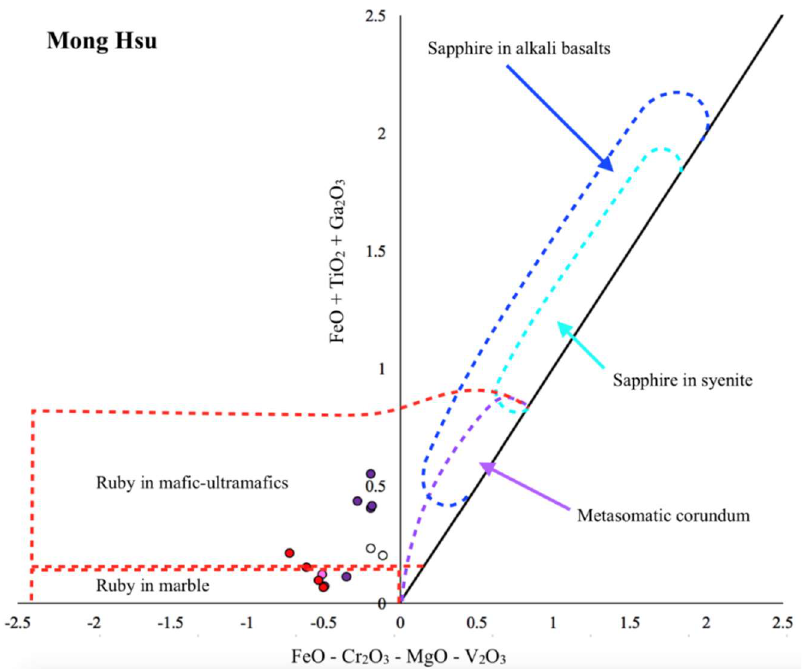
Figure 16. Discrimination metal oxide plots, with petrological fields after [3], for Mong Hsu ruby analyses. The plots are color-coded in relation to red, violet-blue-black and white zoning.